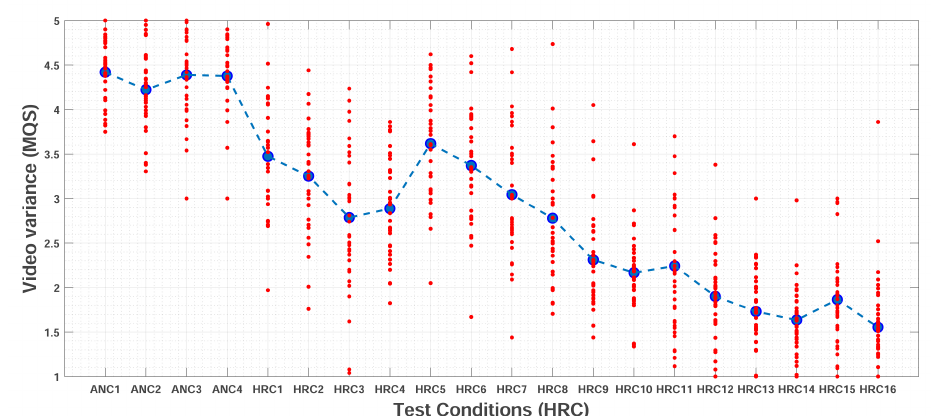
Figure 9. Mean Quality Score (MQS), and its respective spread of scores, for the different Hypothetical Reference Circuit (HRC) in Experiment